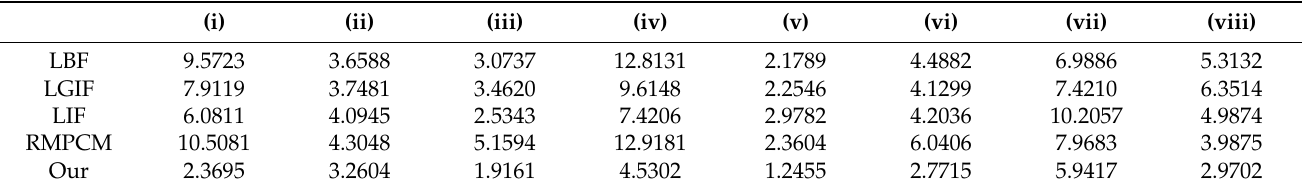
Table 3. The MAE results of LBF, LGIF, LIF, RMPCM, and our method in Figure 5.